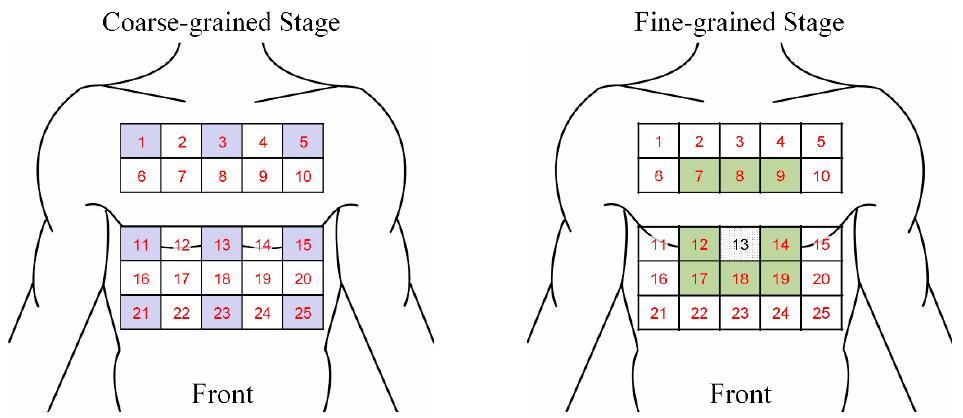
Figure 7. Optimized electrode locations determination using one WFEES module based on the L91S method.